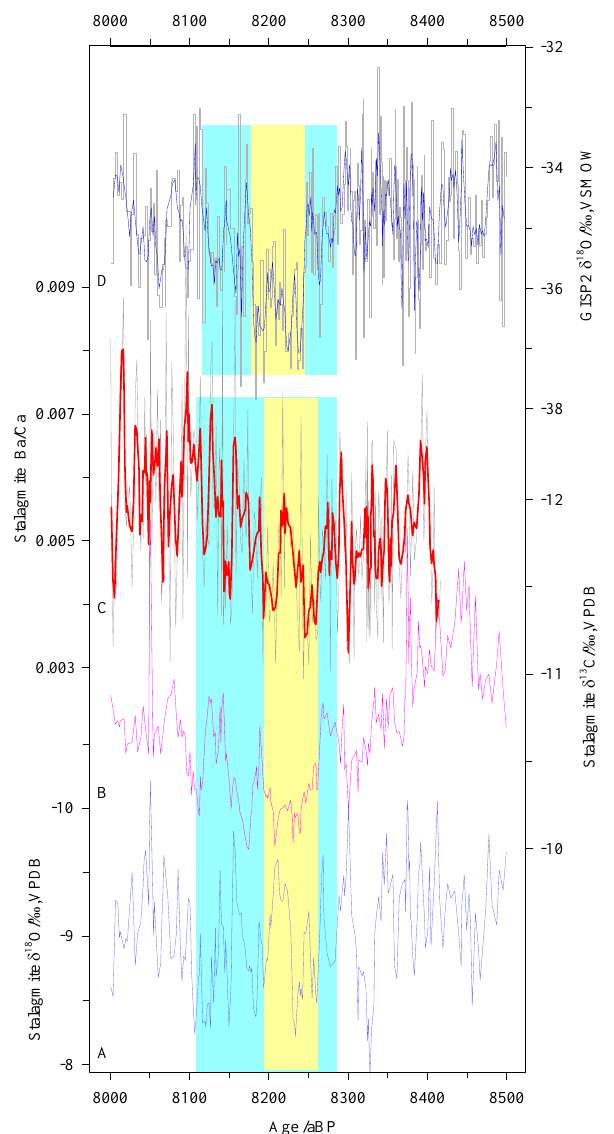
Fig. 6. Detailed comparison of multi-proxy records from stalagmite NH33- δ 18 O (A) ; δ 13 C (B) ; Ba/Ca (C) ; and GISP2 δ 18 O record (D) (Stuiver and Grootes, 2000). The blue and yellow blocks indicate the 8.2ka event and its central vale, respectively. All records are plotted on their respective time scales, in years before 1950AD.